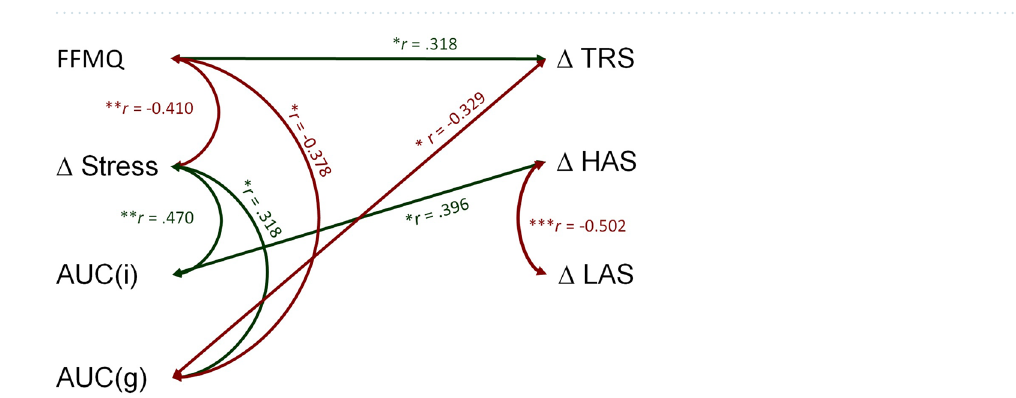
Figure 5. The high arousal state (HAS) and low arousal state (LAS) are coupled and change in tandem across state in two different datasets, ( a ) due to stress, and ( b ) as a result of 24 h of total sleep deprivation.